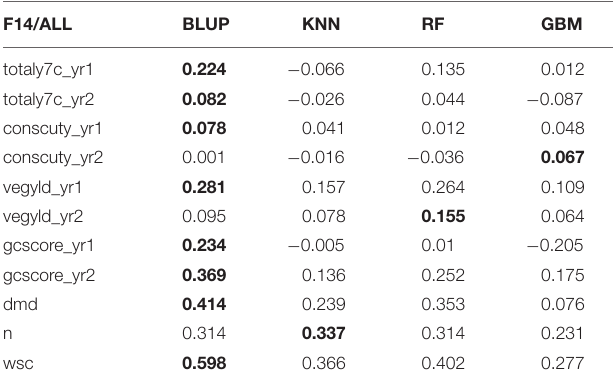
TABLE 4 | Correlation between observed phenotyped and GEBV predicted by the four methods trained on ALL (INT + Late F5). F14/ALL BLUP KNN RF